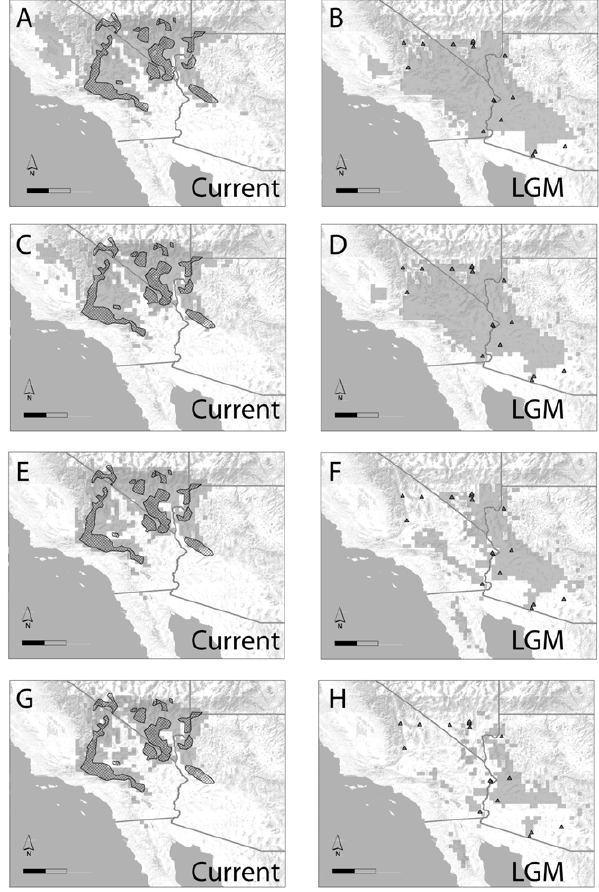
Figure 4. Estimated potential distribution for Yuccabrevifolia (shaded cells) under current climate conditions (left column), and at the last glacial maximum (LGM) (right column). Distributions were inferred using boosted regression trees (panels A– D) and maximum entropy (panels E–H). For each algorithm, thresholds were set at values that either maximized sensitivity and specificity (panels A–B and E–F), or where sensitivity and specificity were equal (panels C–D and G–H). For comparison, the locations of 29 palaeor- ecords for Y. brevifolia from 13KYA or earlier are shown as grey triangles; the actual current range of Y. brevifolia is shown as cross-hatched polygons. Scale bars are 200 km.